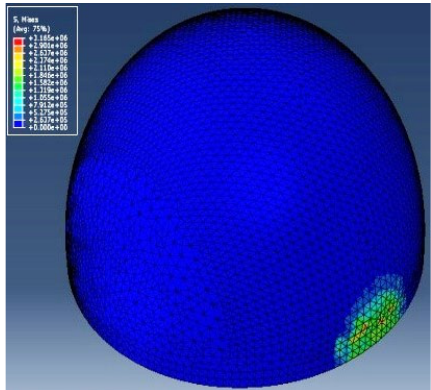
Fig. 20. Von misses composite stress contour in spherical building in a moment after explosion strikes building at height of 6 meters above the